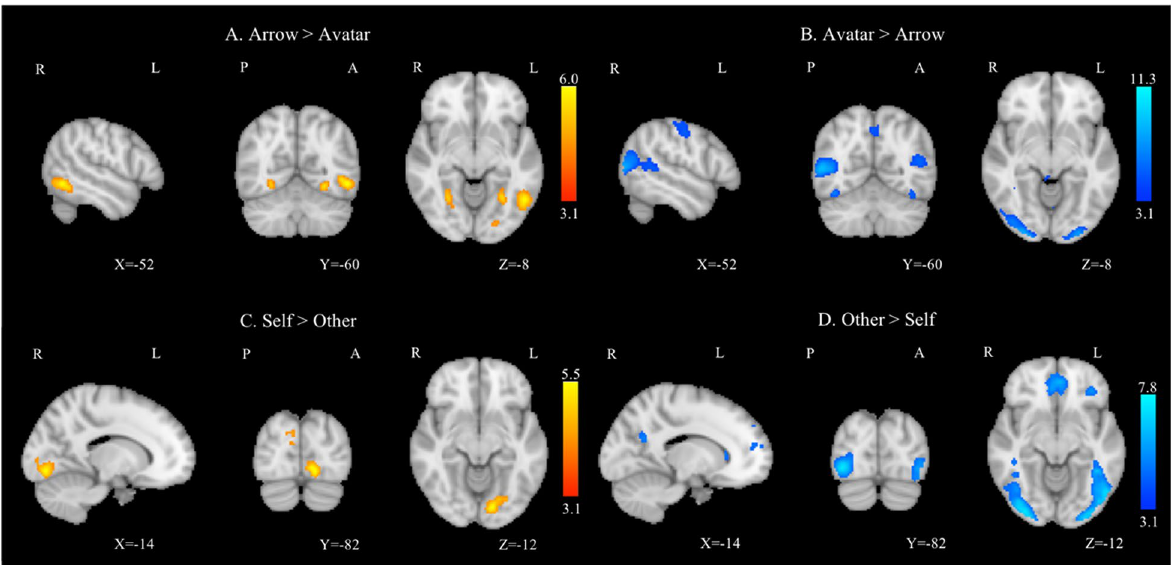
Figure 1. Group average task-related GLM analysis for the contrast Arrow > Avatar ( A ) and for the inverse comparison Avatar > Arrow ( B ), and for the contrasts Self > Other ( C ) and Other > Self ( D ). Right hemisphere on the left side, all clusters were thresholded by Z > 3.1 and a corrected cluster significance threshold of p =